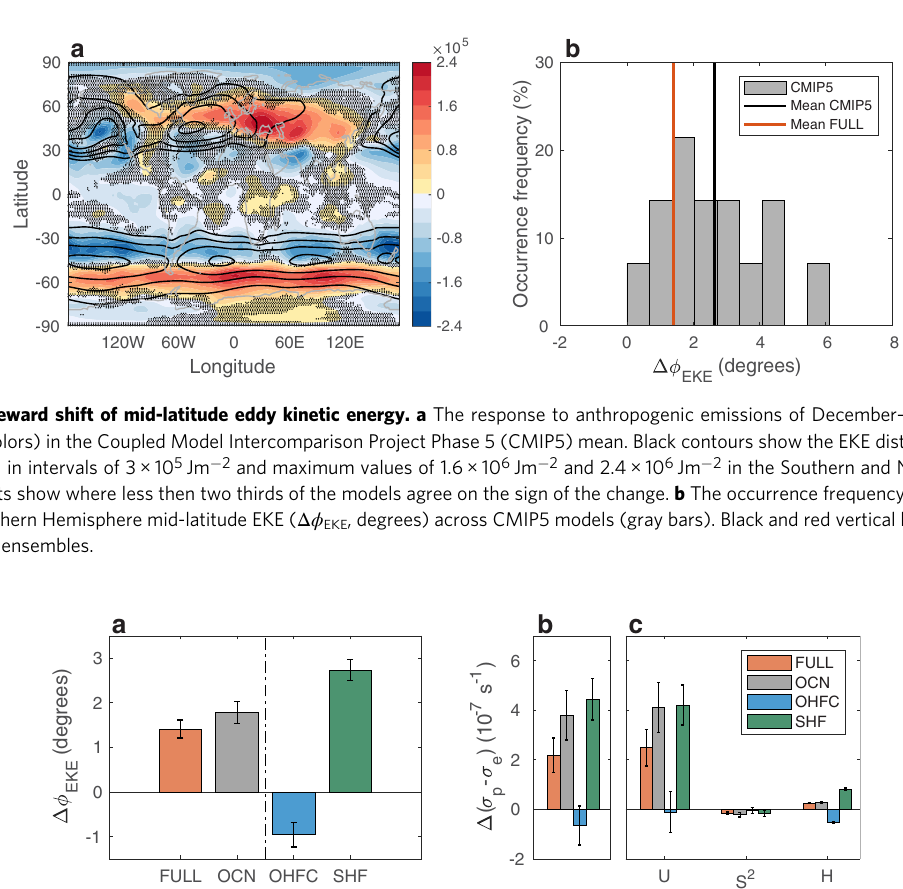
Fig. 2 The role of ocean coupling in the poleward shift of mid-latitude eddy kinetic energy. a The projected shift in eddy kinetic energy ( Δ ϕ EKE , degrees) in the mean of the FULL ensemble (red bar), and the relative contribution to the shift of the EKE from ocean coupling (gray bar, difference between FULL and NOM), and from decomposing the ocean coupling to dynamic coupling (OHFC, blue bar, difference between FULL and SOM) and thermodynamic coupling (SHF, green bar, difference between SOM and NOM). b The response to anthropogenic emissions of the growth rate on the poleward fl ank of the EKE, relative to the equatorward fl ank ( Δ ( σ p − σ e ), 10 − 7 s − 1 ). c The relative contribution to the growth rate response from the mean zonal wind ( u ), static stability ( S 2 ) and tropopause height ( H ) in the FULL ensemble (red bars), and the contributions from ocean coupling (gray bars), thermodynamic coupling (SHF, green bars) and dynamic coupling (OHFC, blue bars). The error bars show the 95% con fi dence interval based on a Student ’ s t-distribution.